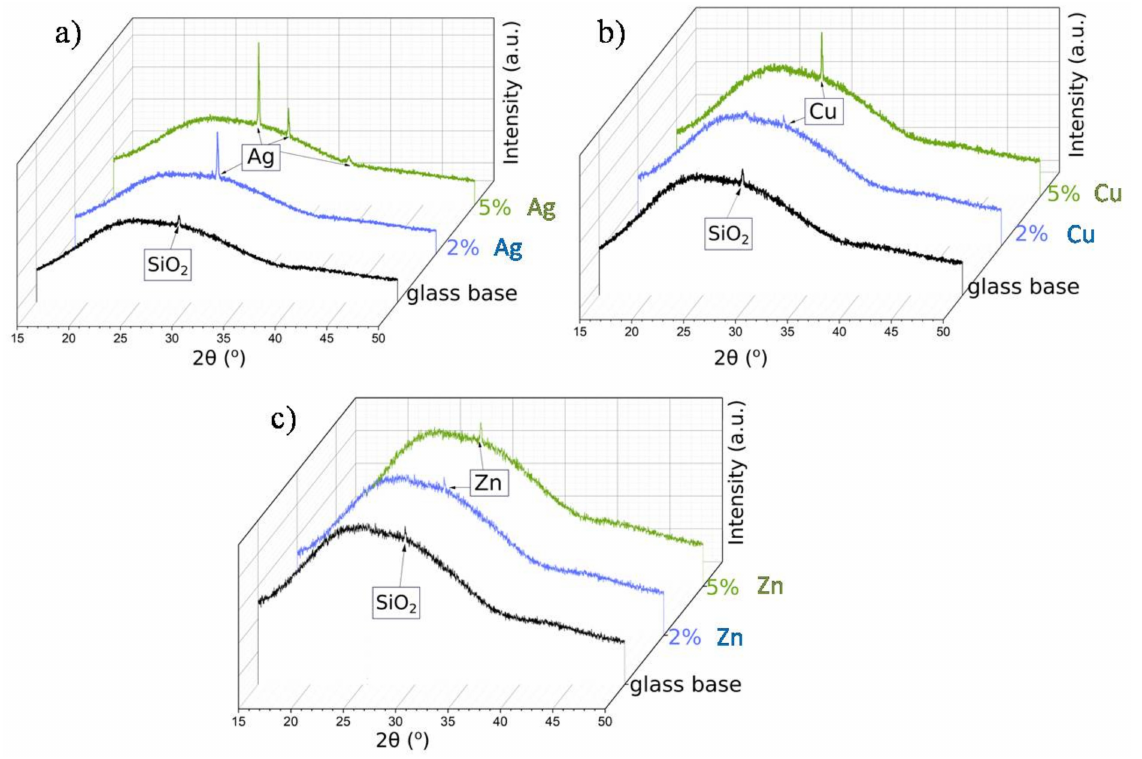
Figure 5. XRD patterns of the metallic nanoparticles in SiO 2 matrix on the glassy base: Ag ( a ), Cu ( b ), and Zn ( c ) at various percentage